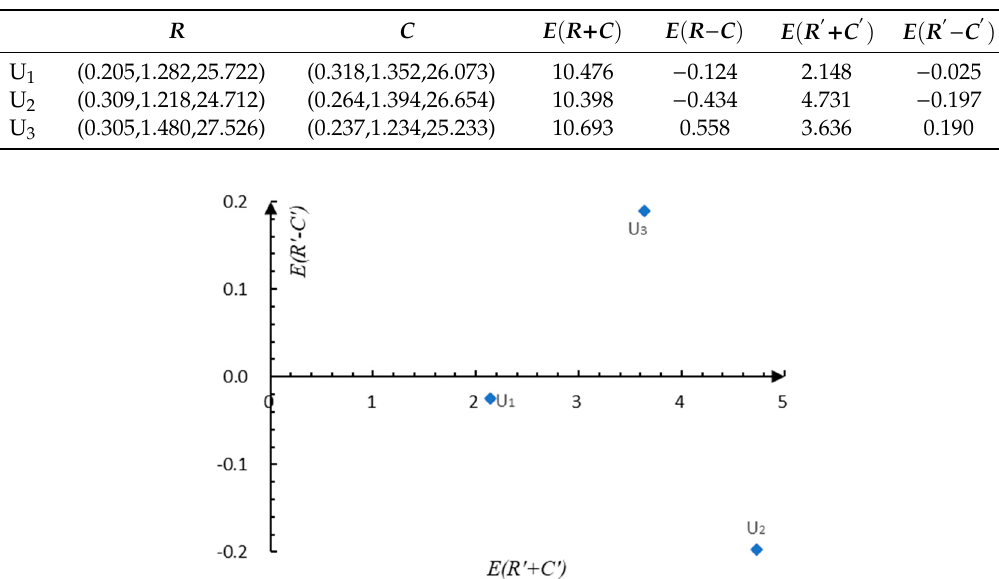
Table 16. The new expected values.